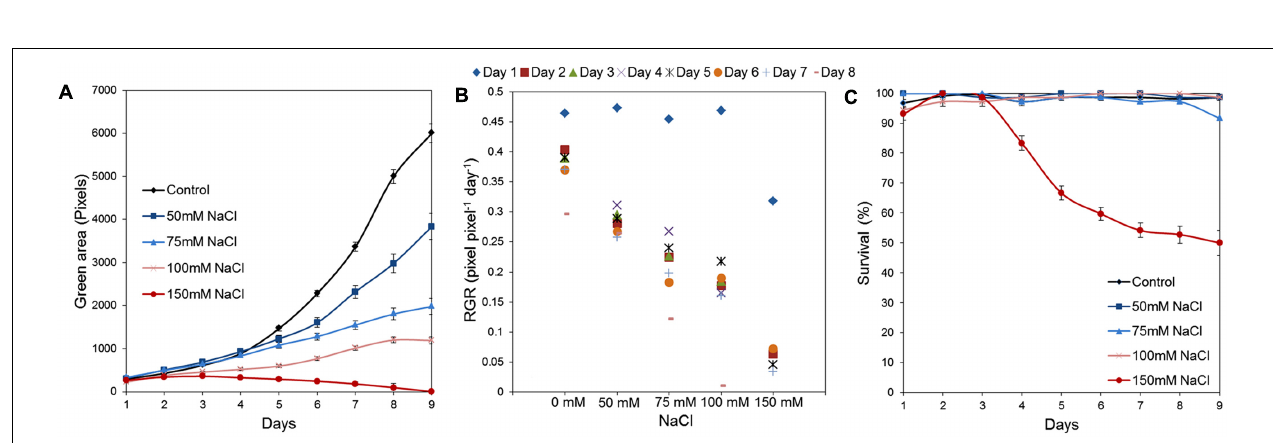
FIGURE 10 | Natural variation in Arabidopsis rosette growth under salt-stress. (A) Green area (pixels) of 4 DAG Arabidopsis seedlings grown in 24-well plates ( n = 48) in 1 × MS with different NaCl concentrations for 9 days. Mean ± SE (B) Relative growth ratio (RGR, pixel pixel − 1 day − 1 ) of 4 DAG Arabidopsis seedlings. (C) Survival (%) of the